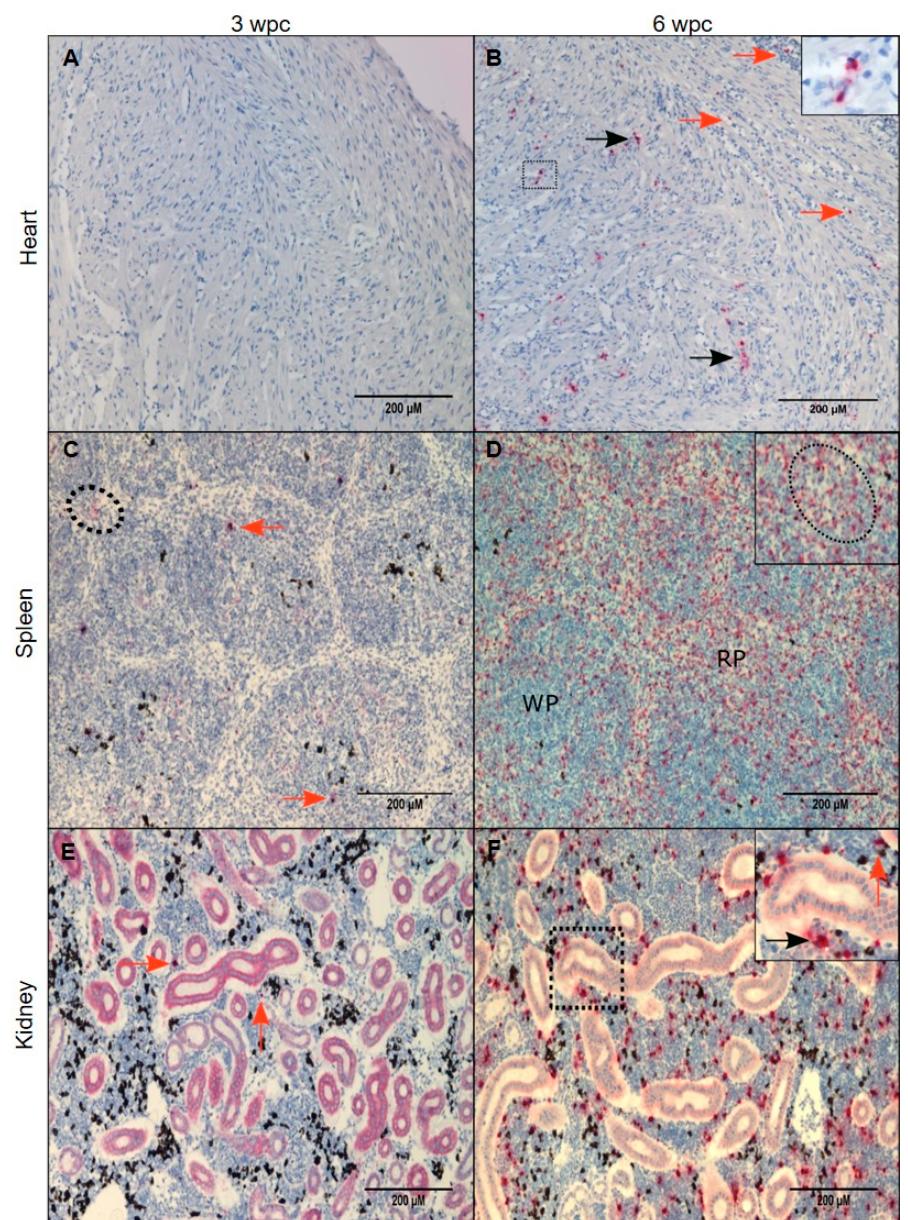
Figure 4. PRV-1 localization in the acute phase. PRV-1 localization shown by in situ hybridization (red) at 3 and 6 wpc. Heart ( A , B ): A, (3 wpc), no PRV detection. B, (6 wpc), PRV positive cardiomyocytes in compact layer (orange arrows) and a few positive erythrocytes or infiltrating macrophage-like cells were present in the epicardium and scattered PRV staining in the spongy layer of the heart ventricle (black arrows). Spleen ( C , D ): C, (3 wpc), few PRV-1 positive RBCs (dotted circle) and macrophage-like cells (orange arrows). D (6 wpc) shows a large number of positively stained cells in the red pulp (RP) area. Dotted circle in magnified version in upper right corner shows cluster of cells with erythrocyte- and macrophage-like morphology. Kidney ( E , F ): E, (3 wpc) shows a few PRV-1 positive cells (orange arrow), primarily macrophage-like cells. F, (6 wpc), a high number of PRV-1 positive macrophage-like cells (black arrow) along with melano-macrophages (orange arrow) were found in peritubular regions of the kidney. Scale bar = 200 µ